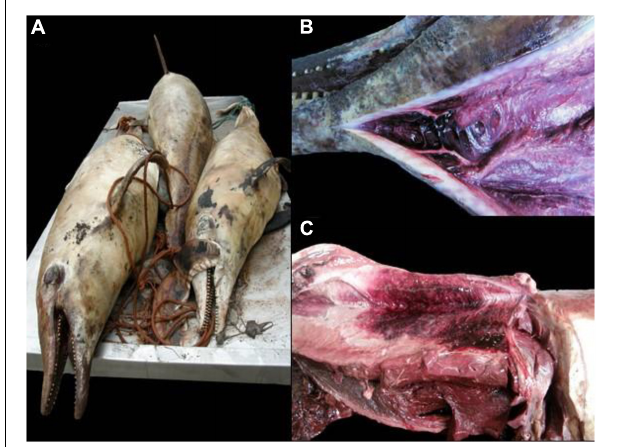
FIGURE 1 | Gross findings in rough-toothed dolphins ( Steno bredanensis ) included in this study. (A) Carcasses exhibit advanced decomposition and autolysis. (B) Focal subcutaneous intermandibular hemorrhage. (C) Focally extensive hemorrhage in the subcutis and axial skeletal muscle on the left thoracolumbar